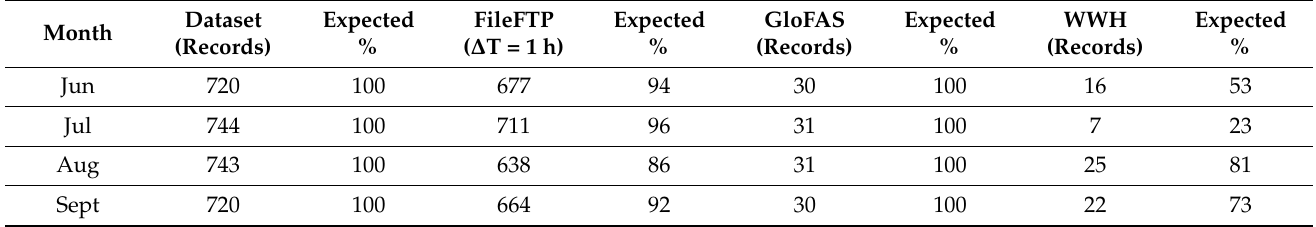
Table 5. Garbey Korou station: dataset consistency, performance in FTP file data transmission, and hydrological forecast